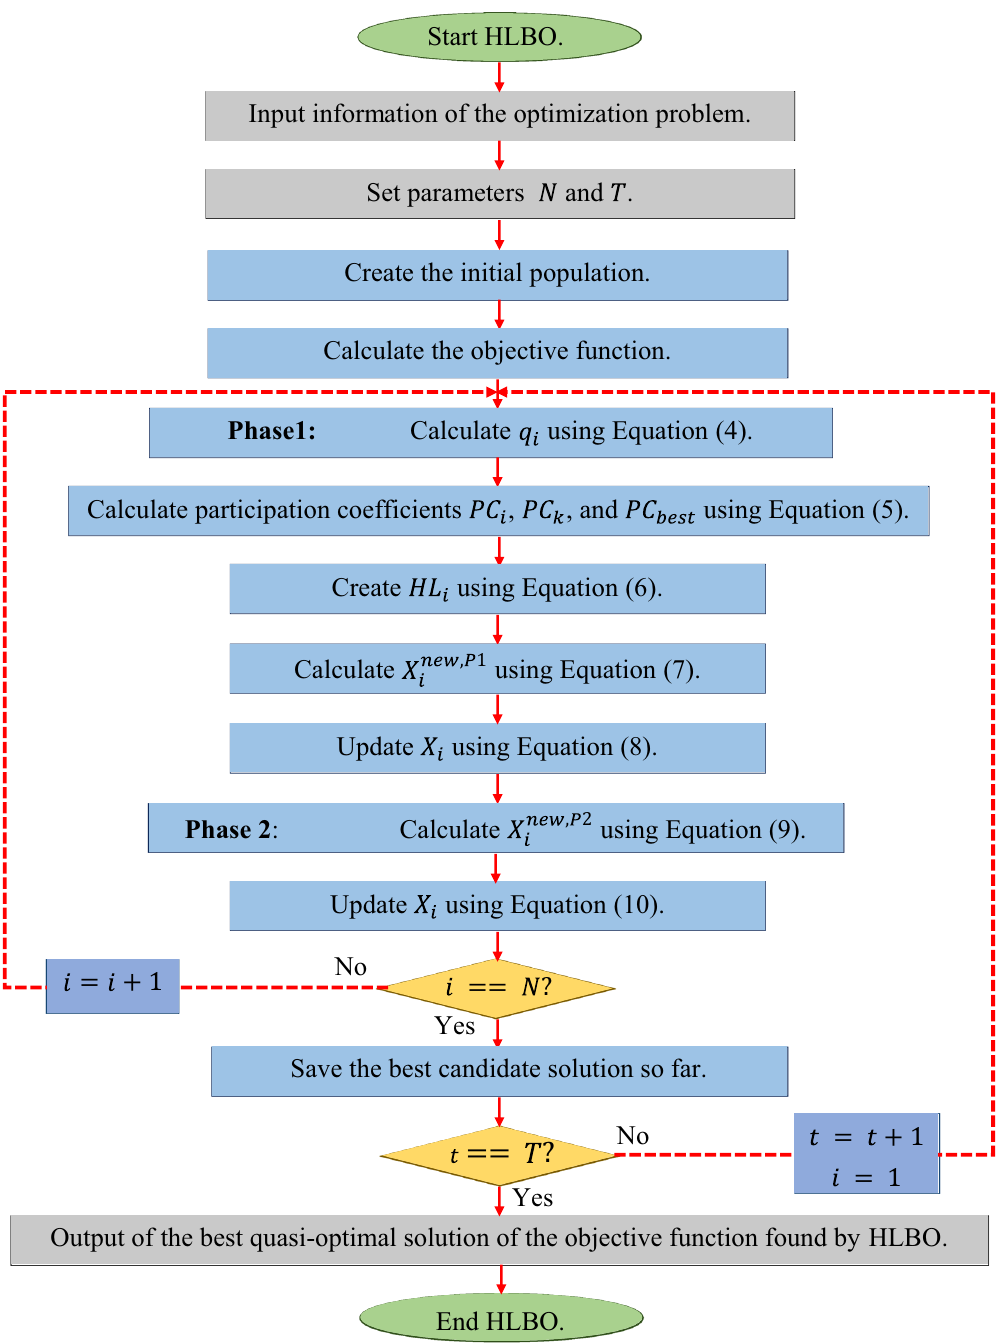
Figure 1. Convergence curves of the HLBO and competitor algorithms in optimizing objective functions F 1 to F 23